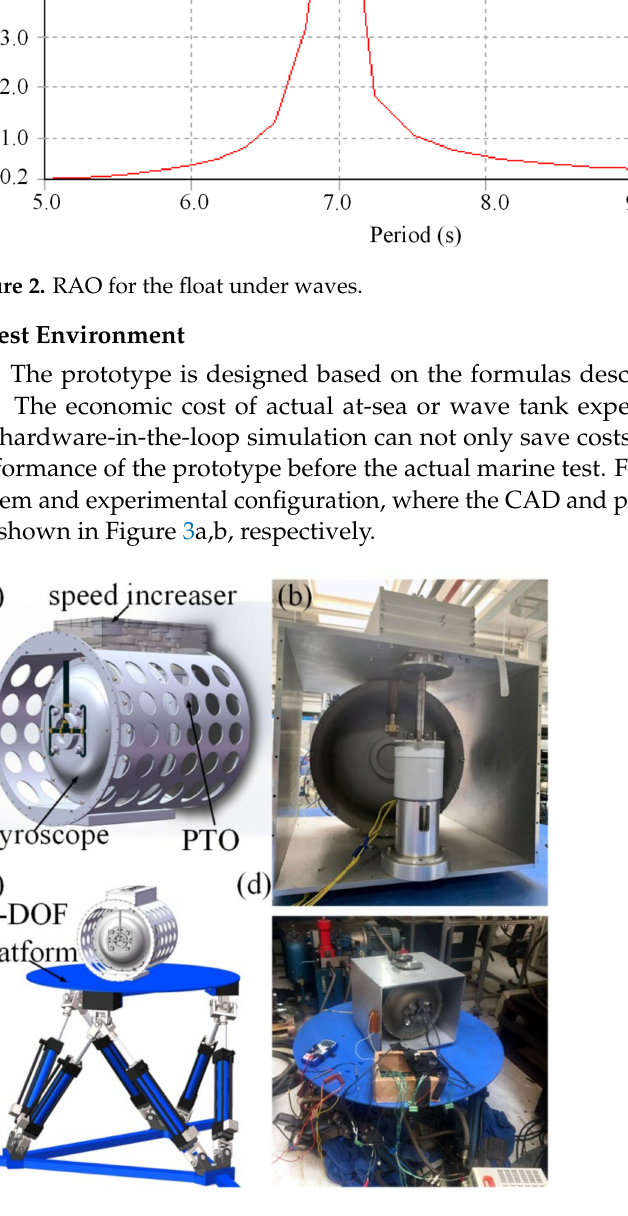
Figure 3. Prototype system and experimental setups: ( a ) CAD of assembly gyroscope; ( b ) GWEC physical prototype; ( c ) CAD of assembly experimental setups; ( d ) experimental